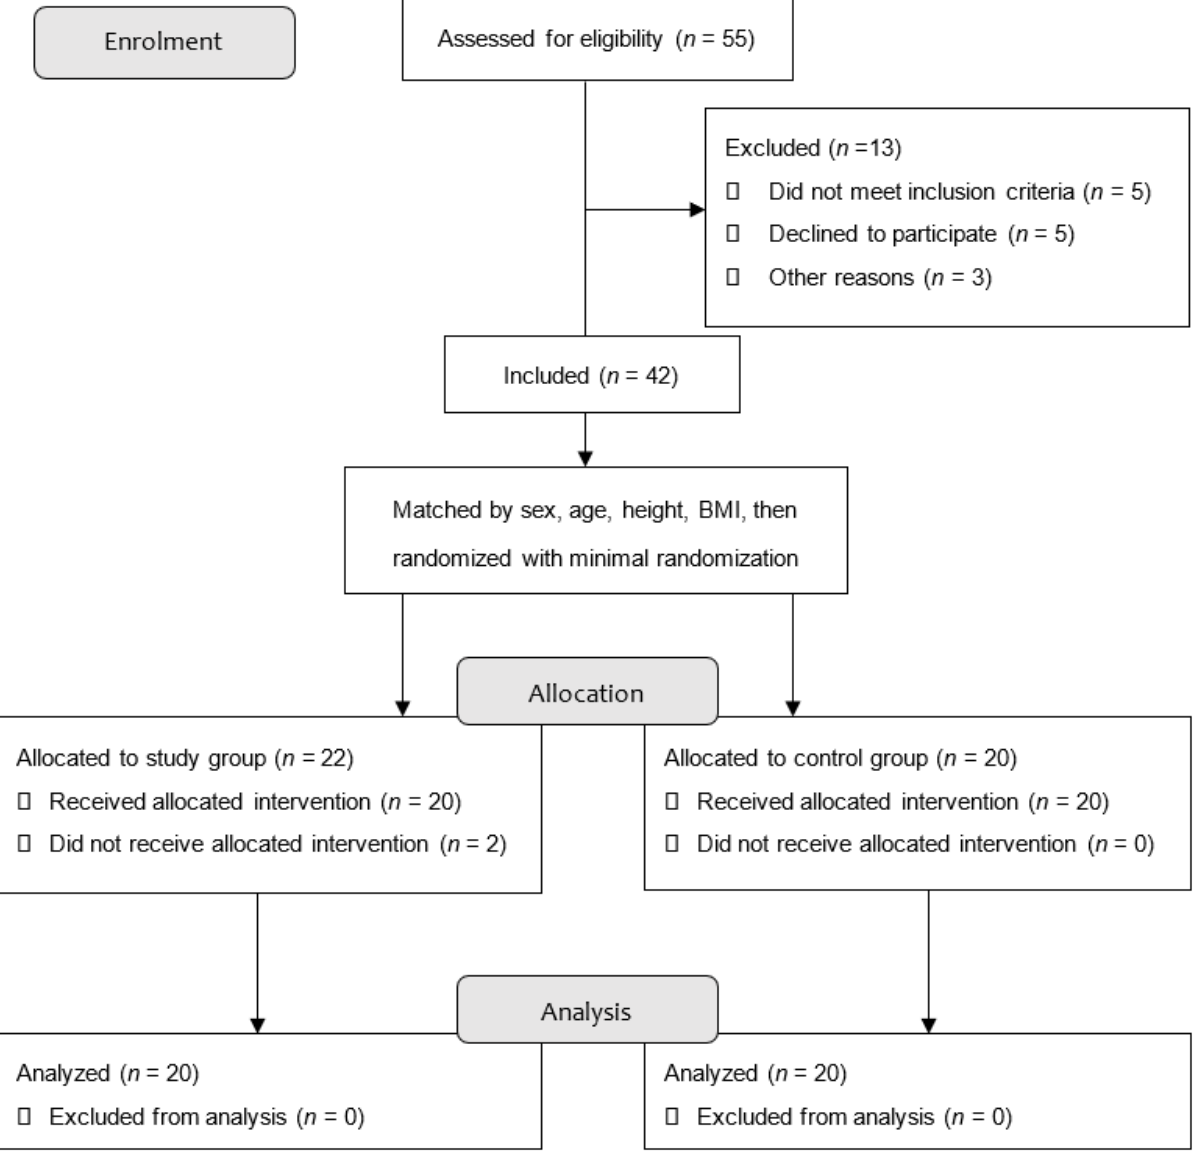
Figure 1. Flow diagram showing experimental design.